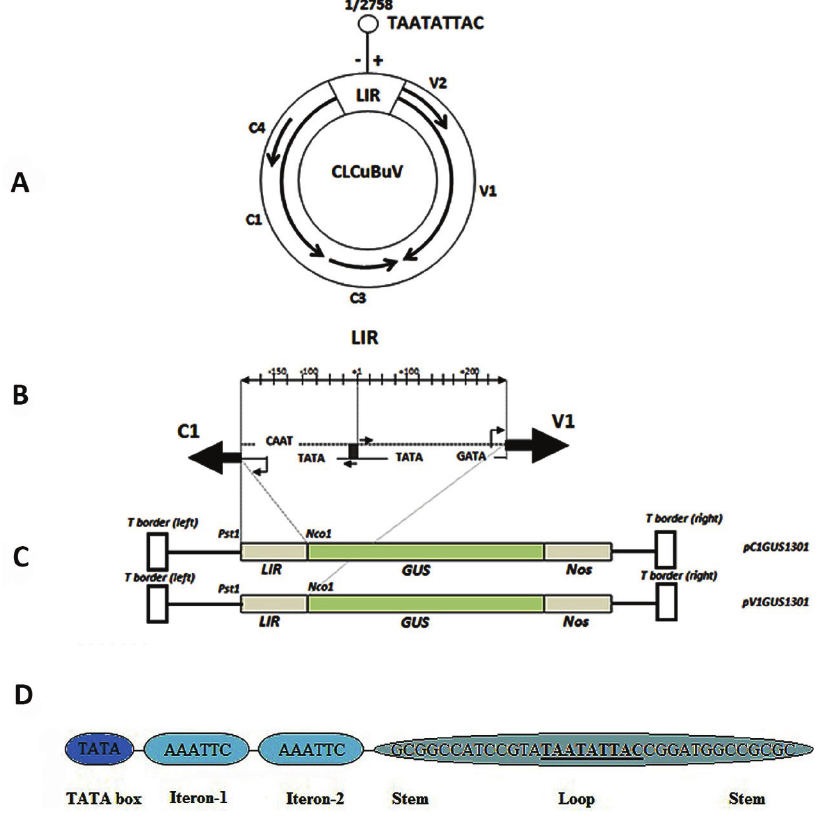
Figure 2. ( A ) Genome organization of the DNA-A component of CLCuBuV . Five ORFs are shown with the arrows. V1 and V2 (coat protein) are located on the plus strand, C1 (replication associated protein), C3 (replication enhancer protein) and C4 (unnamed) are located on the complementary sense strand. The 455 bp large intergenic region (LIR) contains the potential stem-loop with nonanucleotides conserved among all geminiviruses. Sequence numbering begins at base 8 of the conserved nonamer; ( B ) A schematic drawing of the CLCuBuV LIR. Shown, is the invariant loop sequence with the nonanucleotide sequence (grey box) flanked by inverted repeats (short arrows); the viral protein start sites and replication associated proteins; ( C ) A schematic representation of both expression vectors shows the cloning of the C1 and V1 promoters; ( D ) Schematic representation of important features of large intergenic region (LIR) of CLCuBuV including REP-binding sites (iterons), TATA box and structure of hair pin showing nonanucleotide (underlined). The TATA box for Rep promoter was to be present at position 2660–2664 in the genome. Two directly repeats iteron motifs AAATTC were predicted at position 2709–2715; 2715–2721 present downstream to TATA box and immediate upstream to stem-loop motif .The stem-loop motif composed of 35 bp was predicted at position 2738–15 in the CLCuBuV